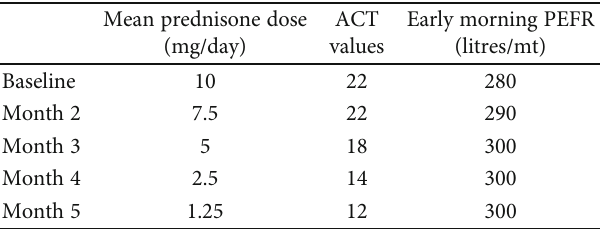
Table 1: Improvement in steroid use, asthma control, and lung function with omalizumab therapy.